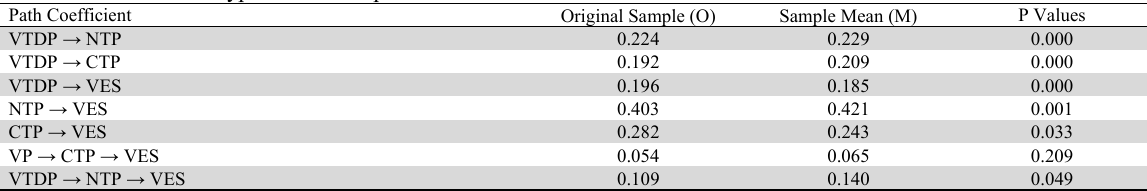
The results of research hypotheses with path coefficient Path